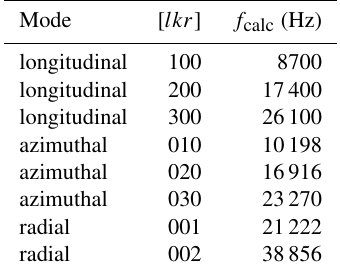
Table 2. Calculated resonance frequency f calc of the first longitu- dinal, azimuthal, and radial modes in the absorption cylinder (with c = 348ms − 1 (N 2 )).